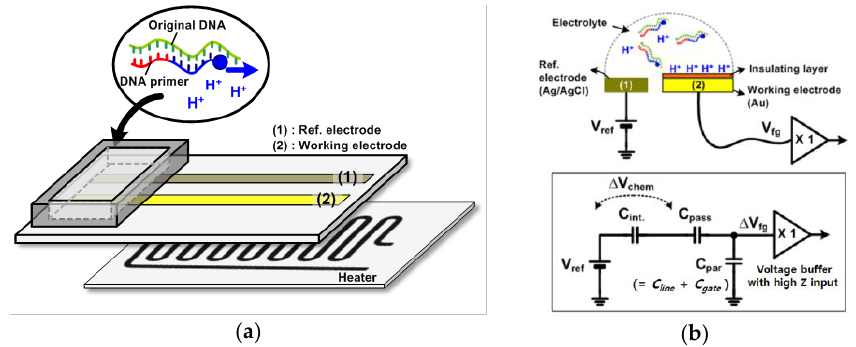
Figure 1. ( a ) Conceptual diagram of an electrochemical chip to amplify nucleic acids; ( b ) electrical models simplified with a first-order